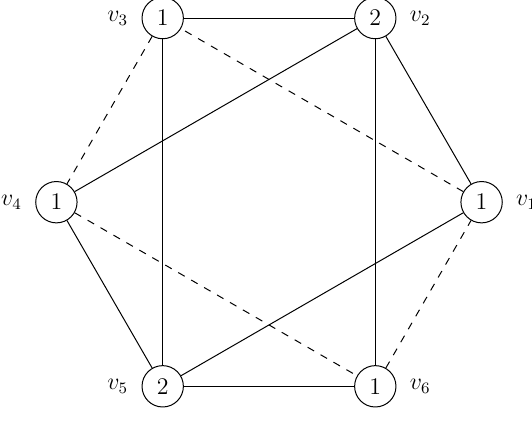
Figure 3 The δ (2) -colouring of C 2